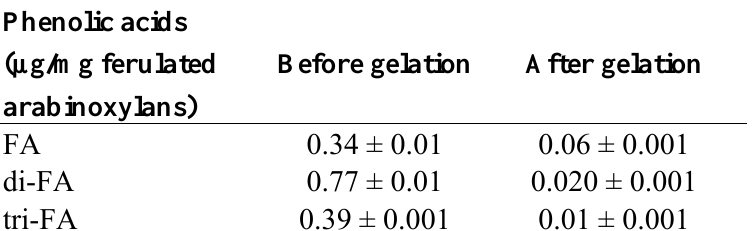
Table 1. Phenolic acids content of ferulated arabinoxylans at 2% (w/v) before and after cross-linking by a laccase from Trametes